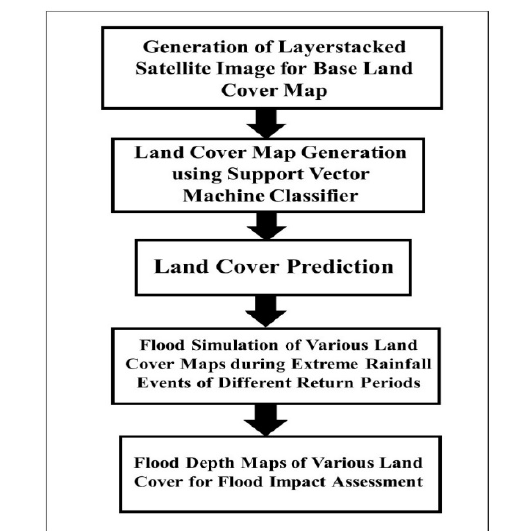
Figure 2. Methodological flow